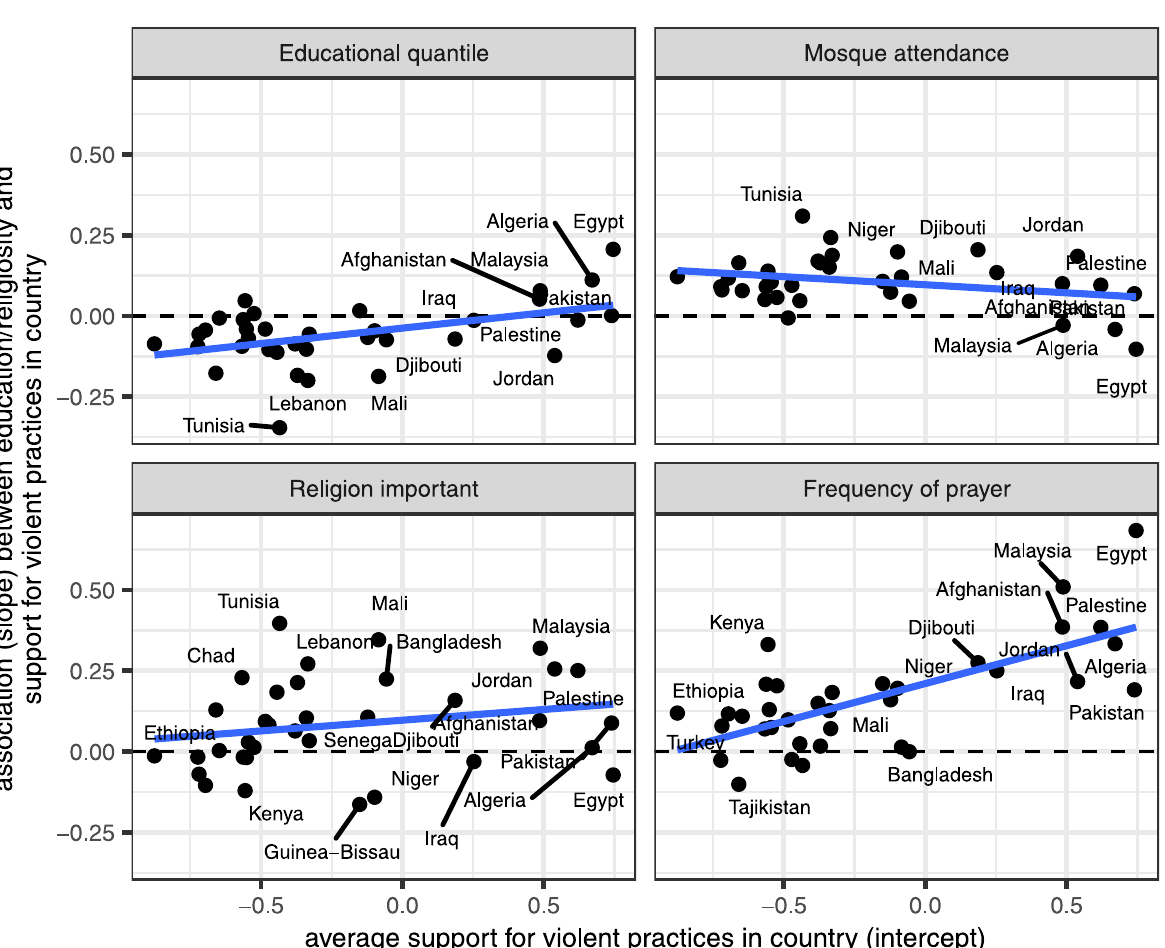
Fig 4. Scatterplot showing the relationship betwen a country’s average level of support for violent practices and the association between education/religiosity and support for violent practices in a country. Values are based on random intercepts and slopes from Model 3 of Table 1. Best fitting OLS line is shown in each